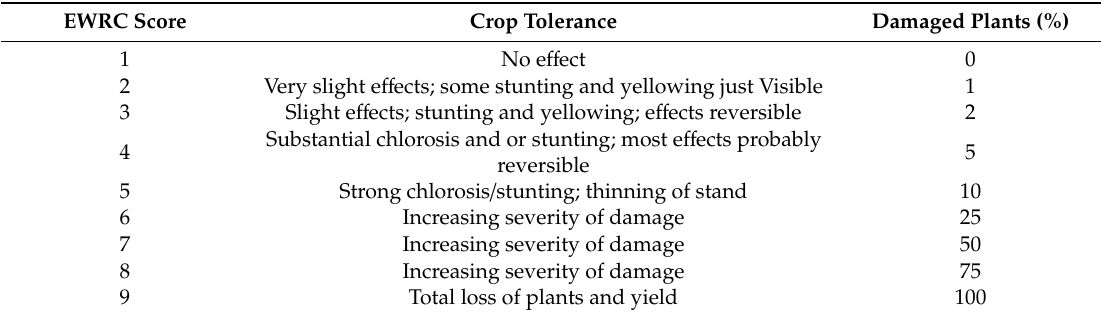
Total loss of plants and yield